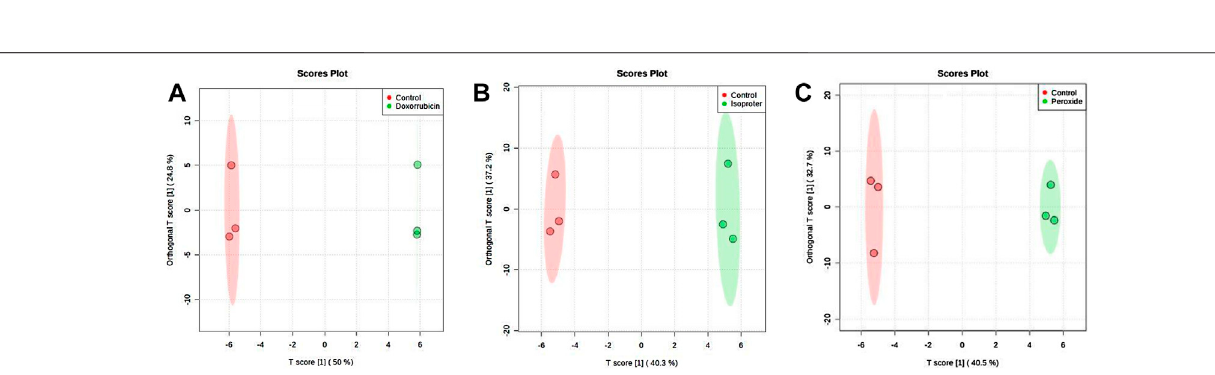
Frontiers in Molecular Biosciences |